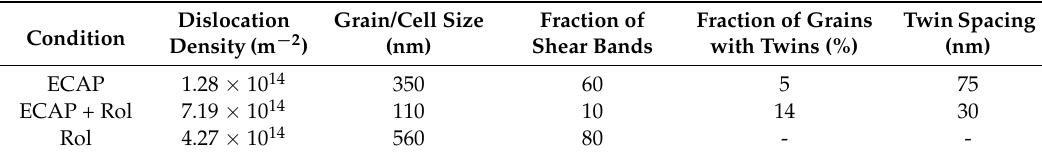
Table 3. Features of the structure of steel after